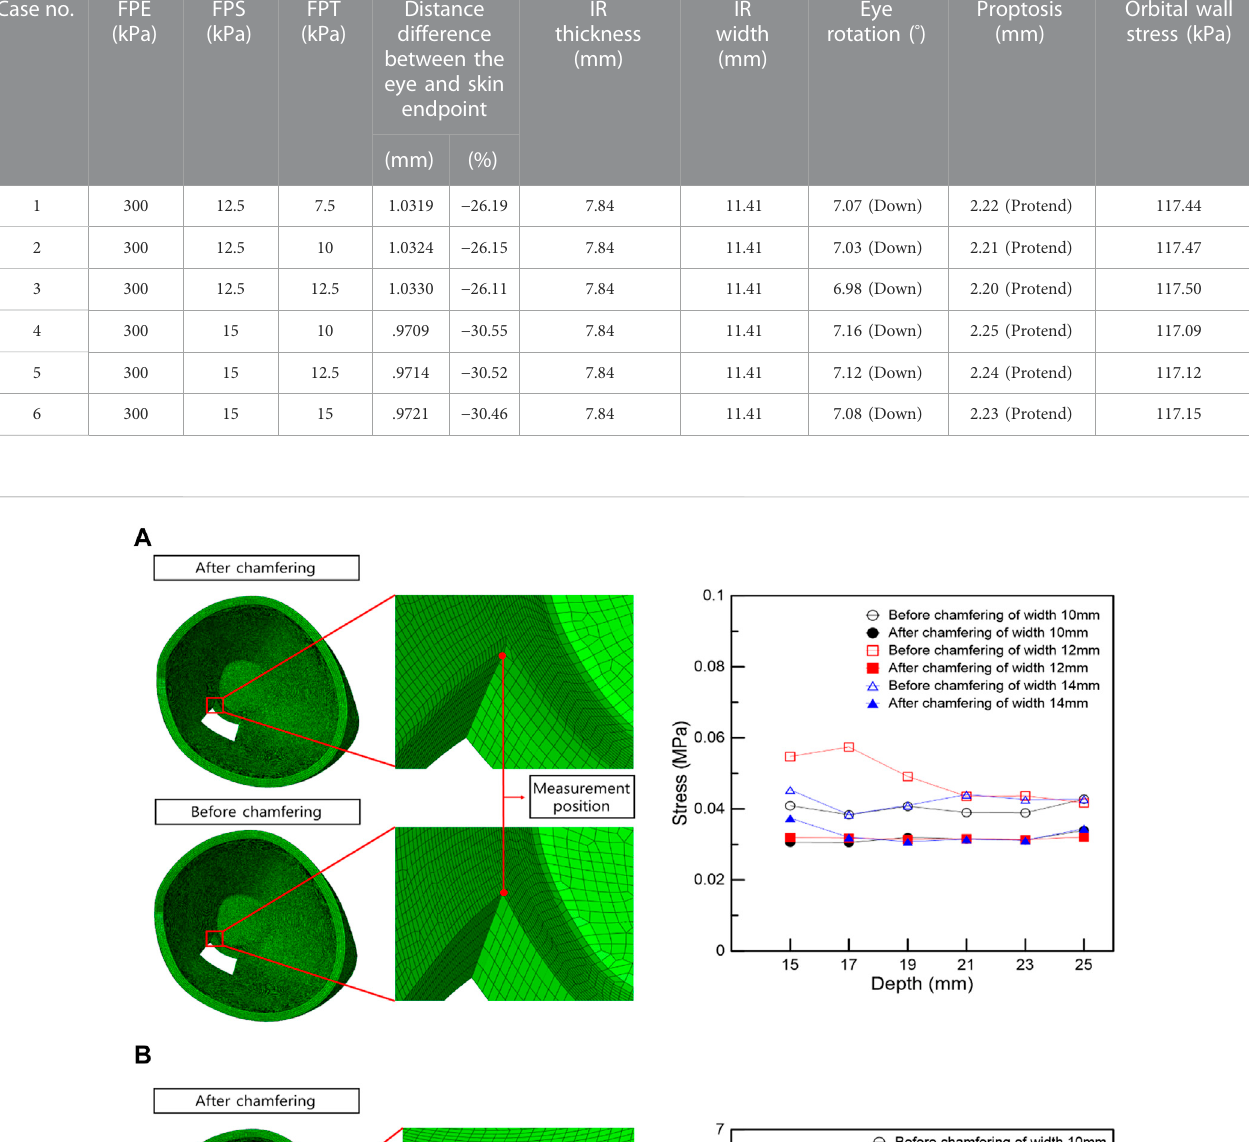
TABLE 5 Main dimensions of IR hypertrophy and the elevated IOP simulation. Case no.